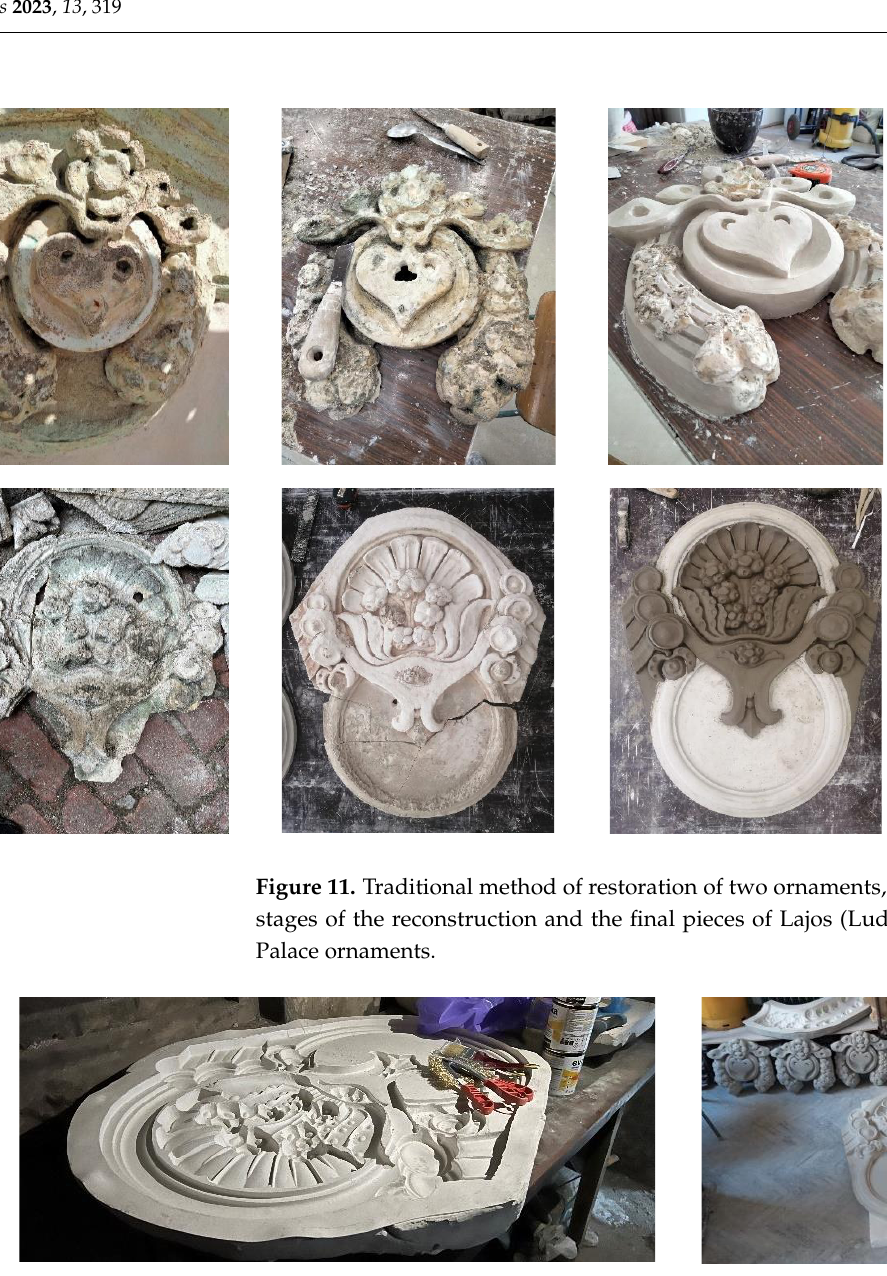
( b ) Figure 10. Technical elevation and 3D view of the Lajos (Ludwig) Besch and Károly (Karl) Piffl Pal- ace ( a ) Front view; ( b ) Roof view. Considering the challenges that the owners had faced with finding skilled sculptors to restore the Art Nouveau ornaments, the authors have decided to experiment with pho- togrammetry to find suitable solutions for similar cases. The following section will de- scribe an inexpensive alternative to scan, model, and 3D print ornaments for molding preparation, as compared to the traditional method used by artists or sculptors who shape the ornament by hand [5,14]. The few sculptors that make these interventions nowadays are rare and expensive since their work requires meticulousness, talent, and hard-working conditions on the scaffold. The traditional method used by sculptors begins with the local restoration of the or- nament, or, if it is very degraded, it is removed from the facade and restored in the work- shop, as seen in Figure 11. Great care must be taken when trying to detach the piece from the facade, as it is ideal for it to remain unbroken. After deep cleaning, when the finishing layers are removed from the ornament, the following step is the reconstruction of the